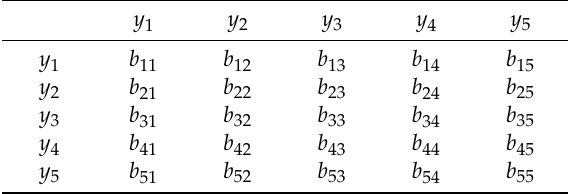
Table 2. The pairwise comparison matrix B of the five indicators.